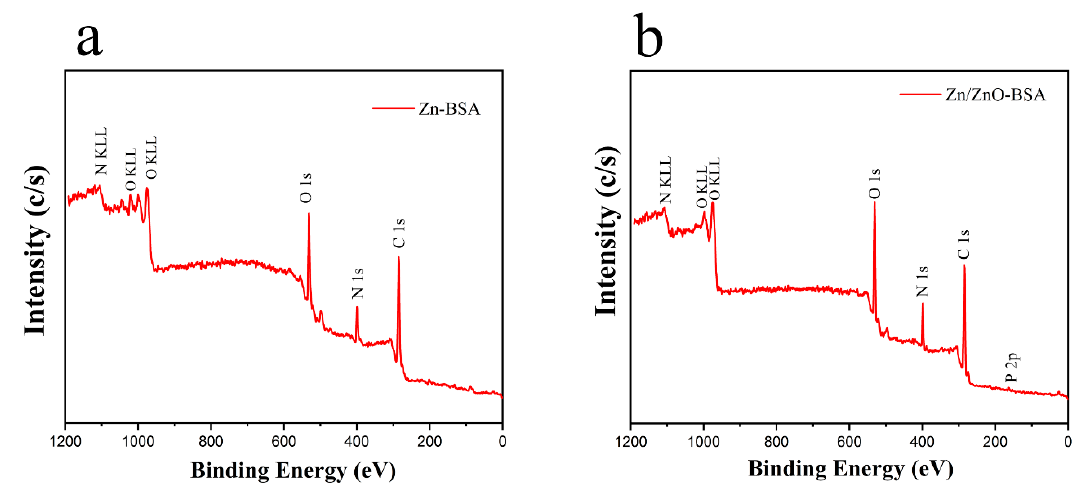
Figure 9. XPS survey spectra for samples after immersion for 21 days in SBF/BSA: ( a ) Zn and ( b ) Zn/ZnO.